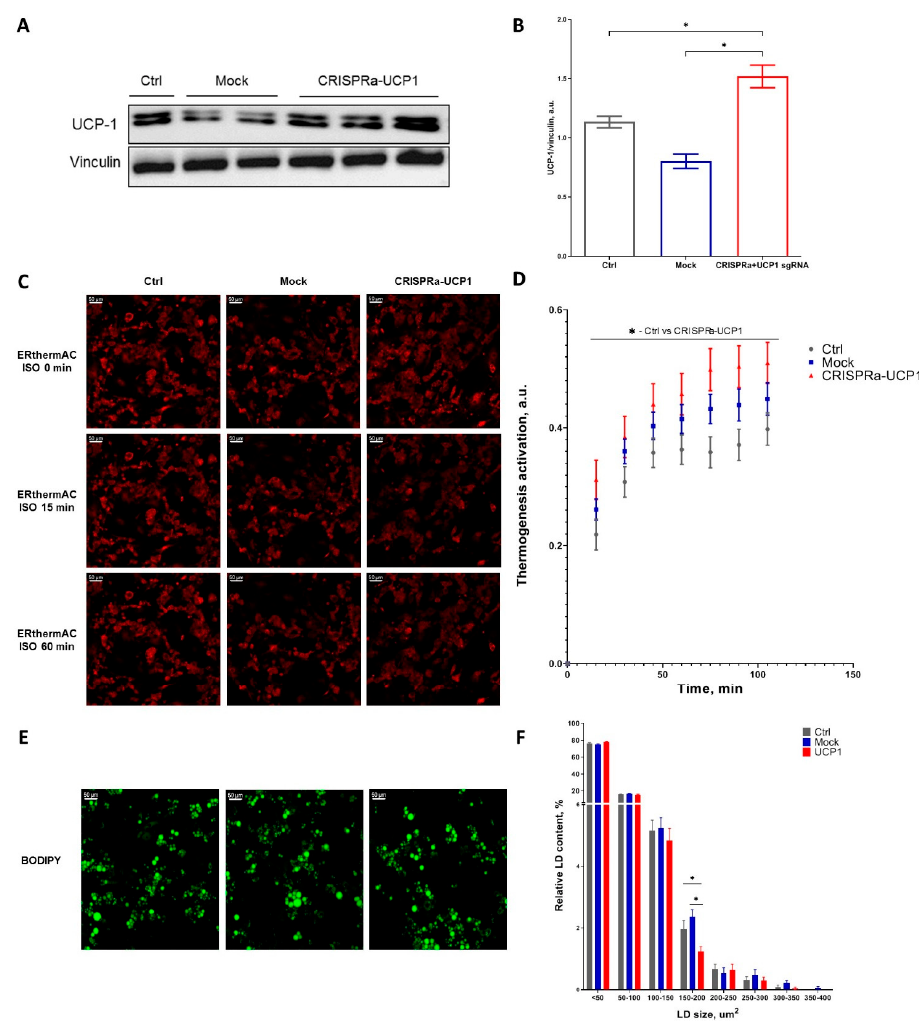
Figure 1. CRISPRa-UCP1 modification of mature adipocytes increased UCP-1 expression, leading to thermogenic activity and a decrease in medium-sized lipid droplet (LD) accumulation. ( A ) A representative Western blot membrane; ( B ) densitometry of Western blots; ( C ) representative im- ages of adipocytes stained with ERthermAC; ( D ) time-dependent curve of thermogenesis activa- tion under isoproterenol stimulation (ISO); ( E ) representative images of adipocytes stained with BODIPY493/503; ( F ) size distribution of LD. Data are presented as mean ± SEM, one way ANOVA test, *—significance threshold p < 0.05.